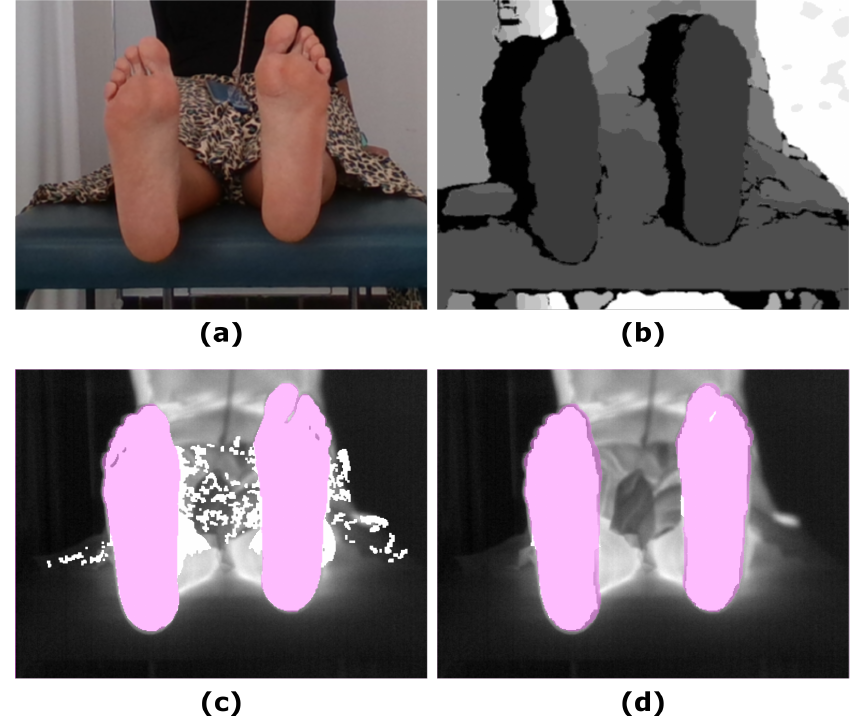
Figure 3. Example showing the final prediction for the Skin approach in which the ground truth has been overlapped (pink mask): ( a ) RGB input image; ( b ) Depth input image; ( c ) IR original image and overlapping Skin final prediction (white mask); ( d ) IR original image and overlapping SPD final prediction (white